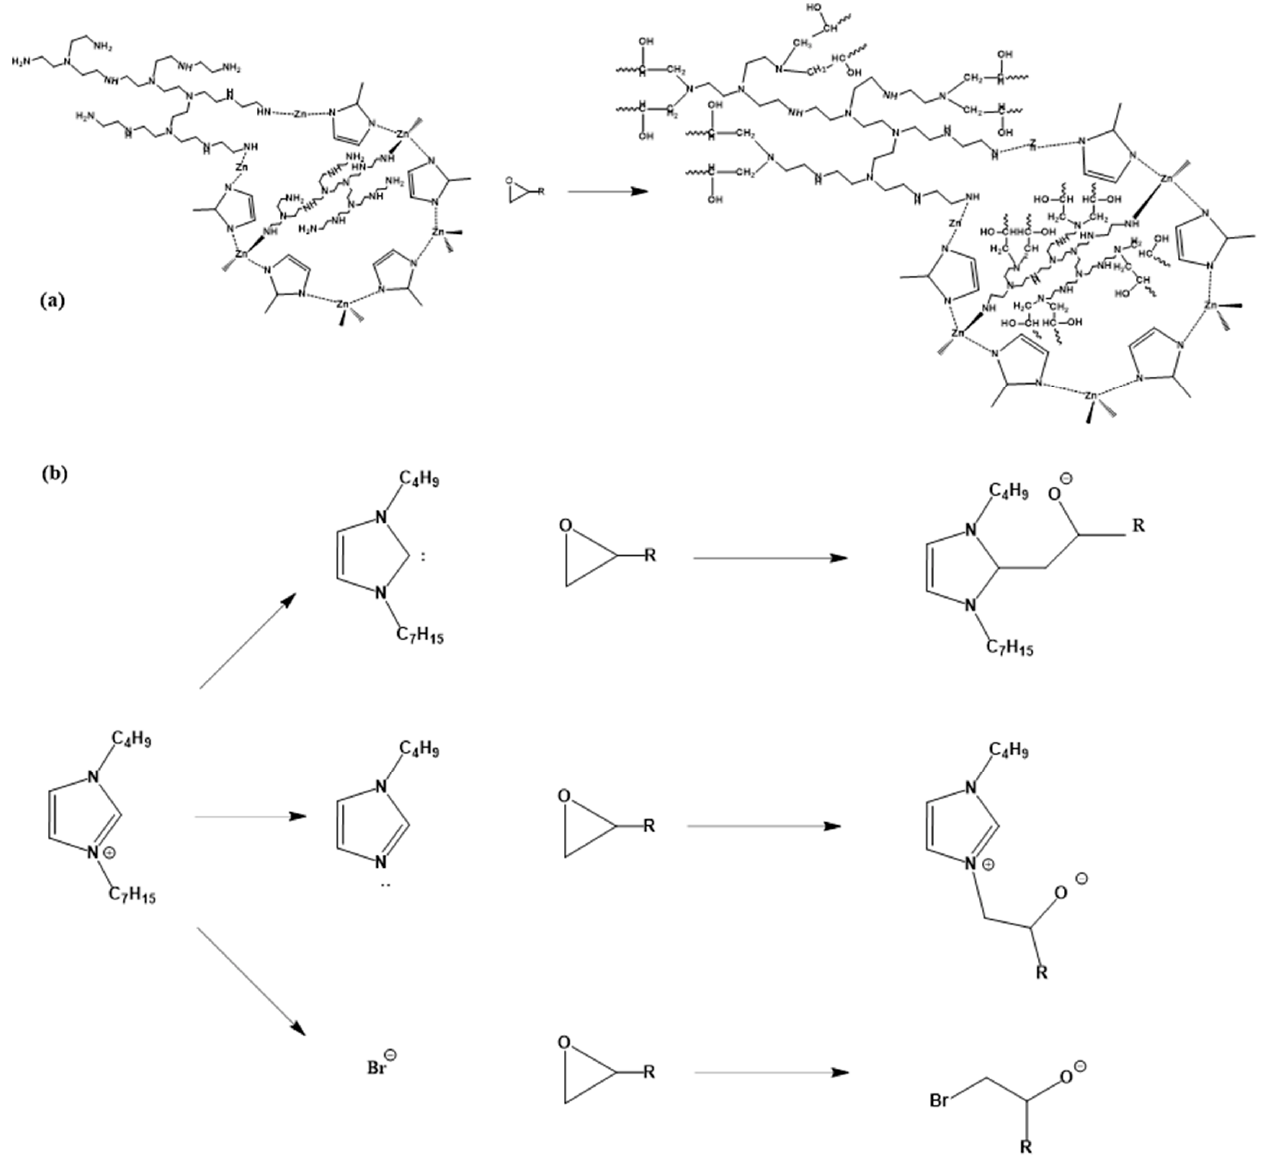
Figure 7. Chemical reactions between BPEI-ZIF-8/IL and EP ( a ) reaction of BPEI-ZIF-8 and epoxy ring, ( b ) reactions of ionic liquid and epoxy ring.